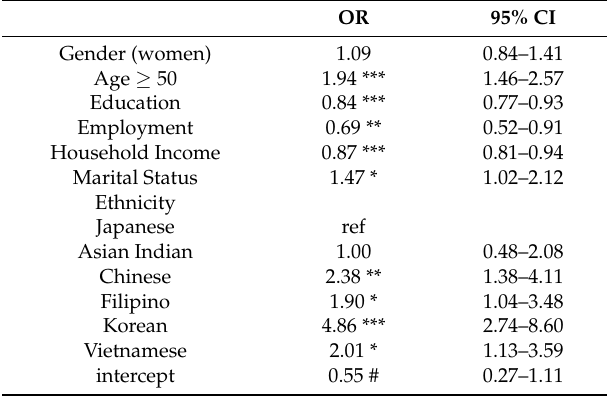
Table 2. Factors associated with poor physical self-rated health (SRH) in the pooled